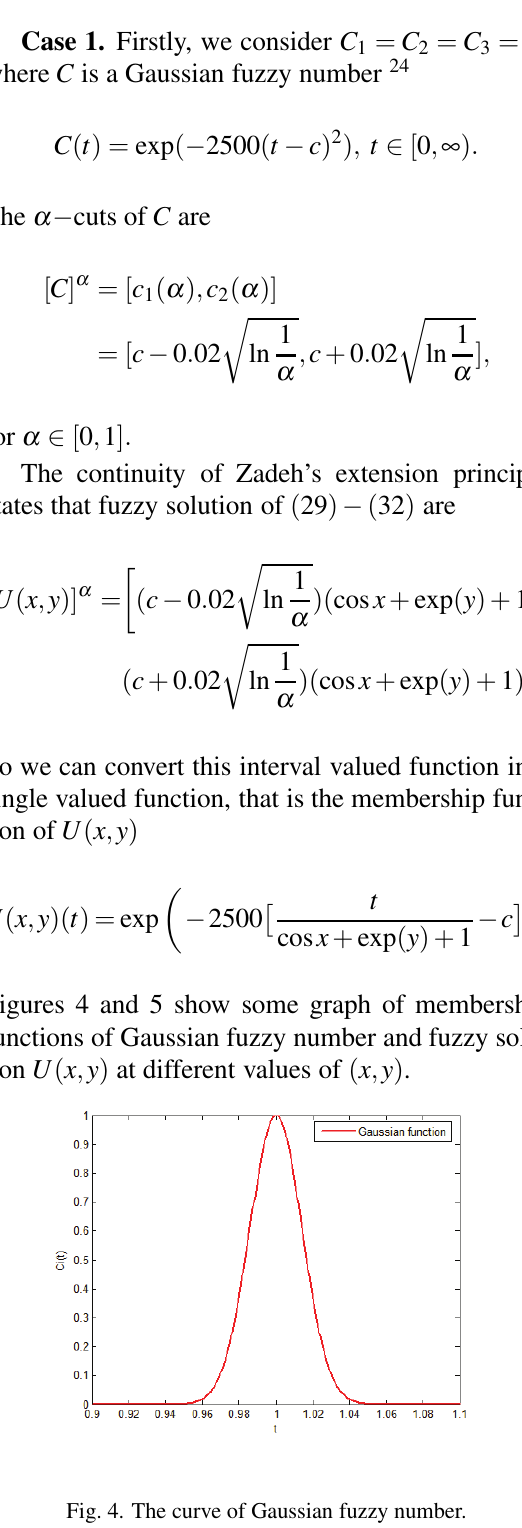
Fig. 4. The curve of Gaussian fuzzy number.